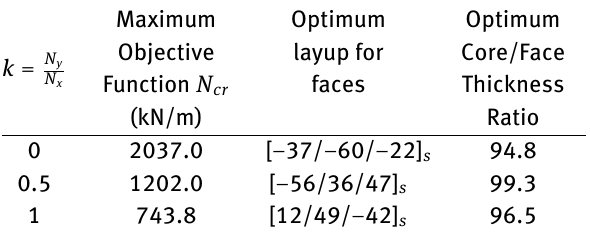
Table 6: Optimisation of a simply supported sandwich cylindrical panel with honeycomb core.